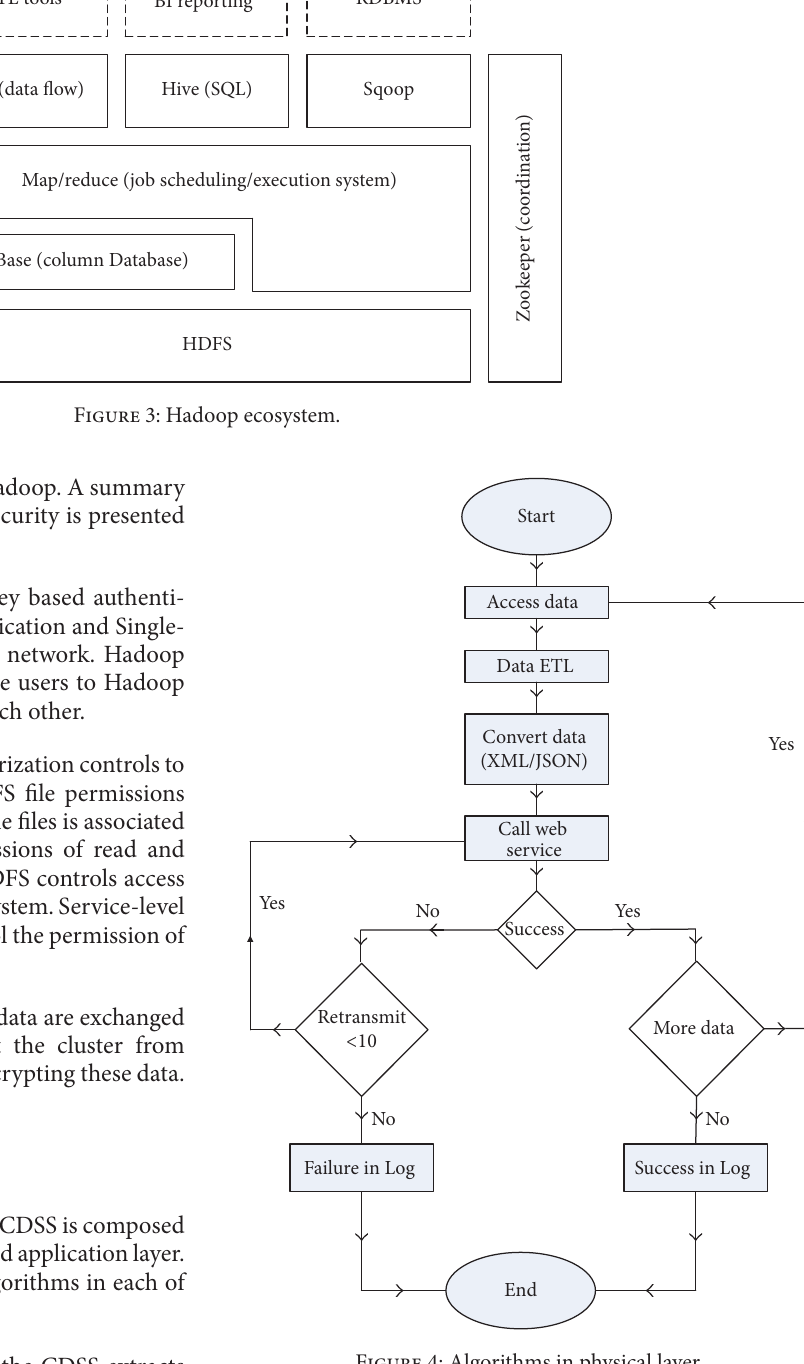
Figure 4: Algorithms in physical